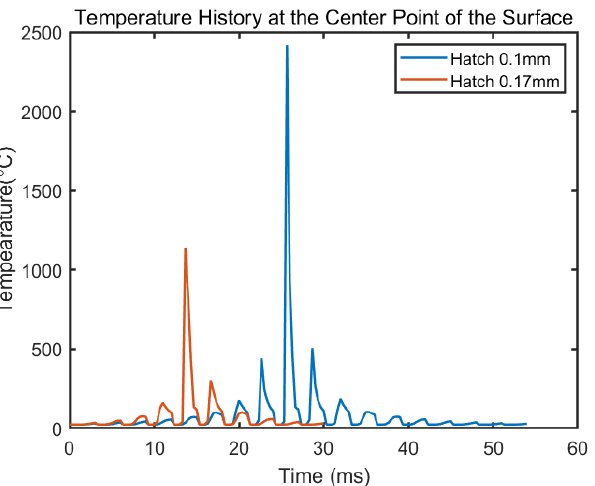
Figure 15. Temperature history of the center point on the fifth layer on a 4 mm 2 square island under a different hatch space with the same process parameters as in Figure 11.